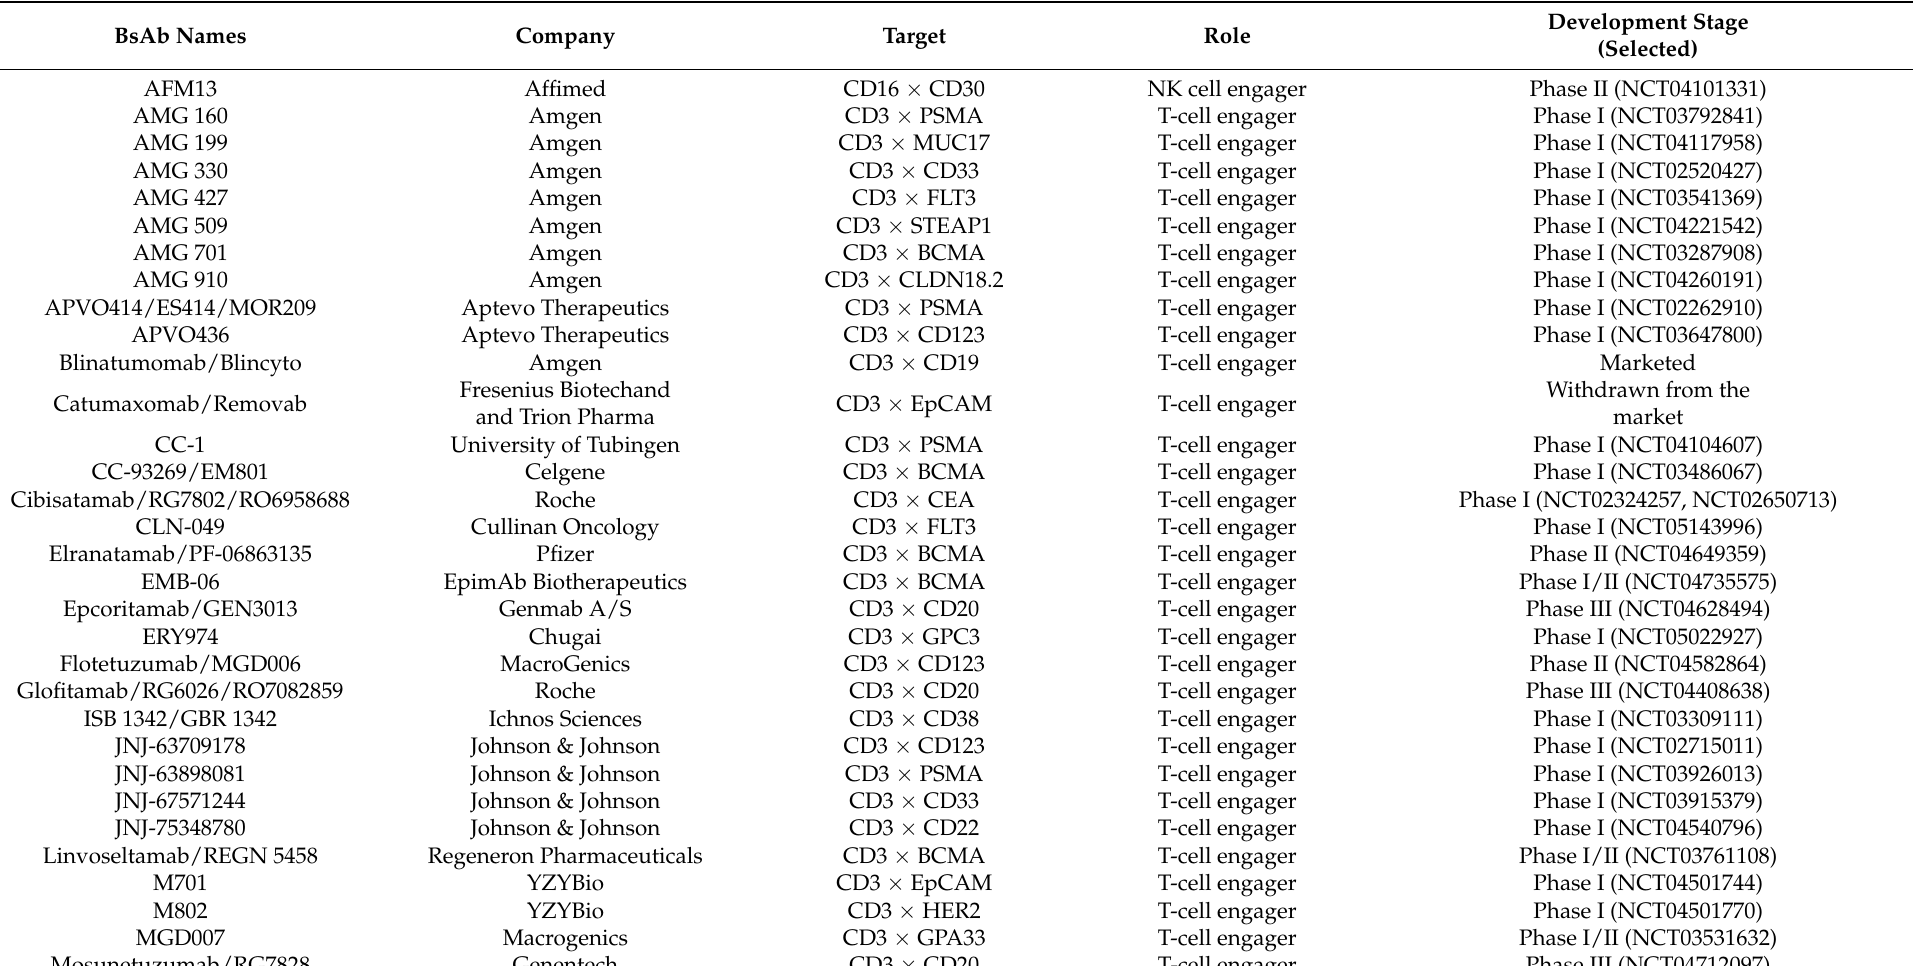
Table 1. Current statuses of bispecific antibody (bsAb)-based immune-cell engagers (ICEs) in clinical studies or bsAb-based ICEs approved by the United States Food and Drug Administration or European Medicines